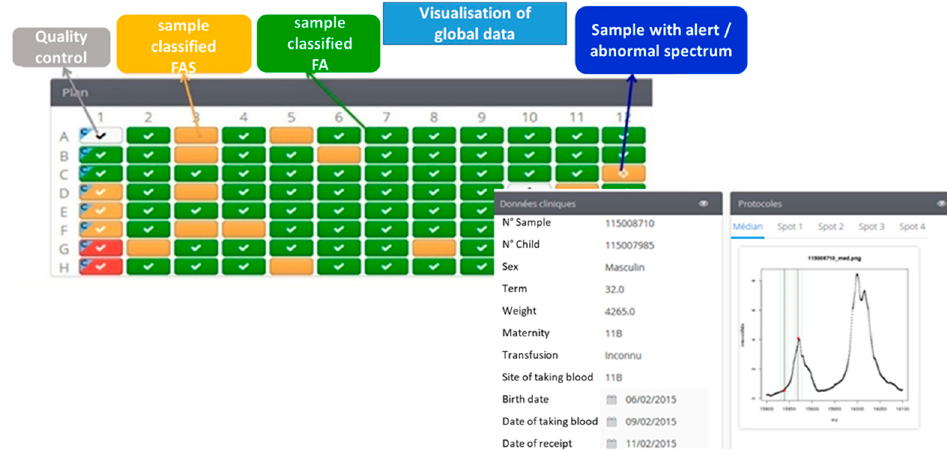
Figure 1. A screen display from the Sickle Cell Anemia Collect & Compare (SCACC) web application. Each box corresponds to a position of a sample on the 96-well plate. The green box corresponds to one sample classified FA, the orange box corresponds to one sample classified FAS and the red boxes are samples detected as FS. The software presents on the same page the clinical data (N° of sample, sex, term, weight, name of maternity, transfusion, location and date of taking blood, birth date) and the spectra of one